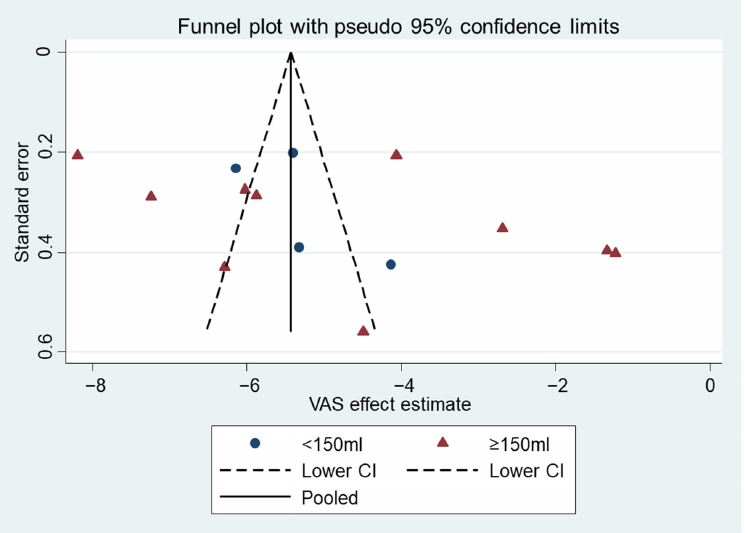
Figure 5. Funnel plot of the VAS mean differences.